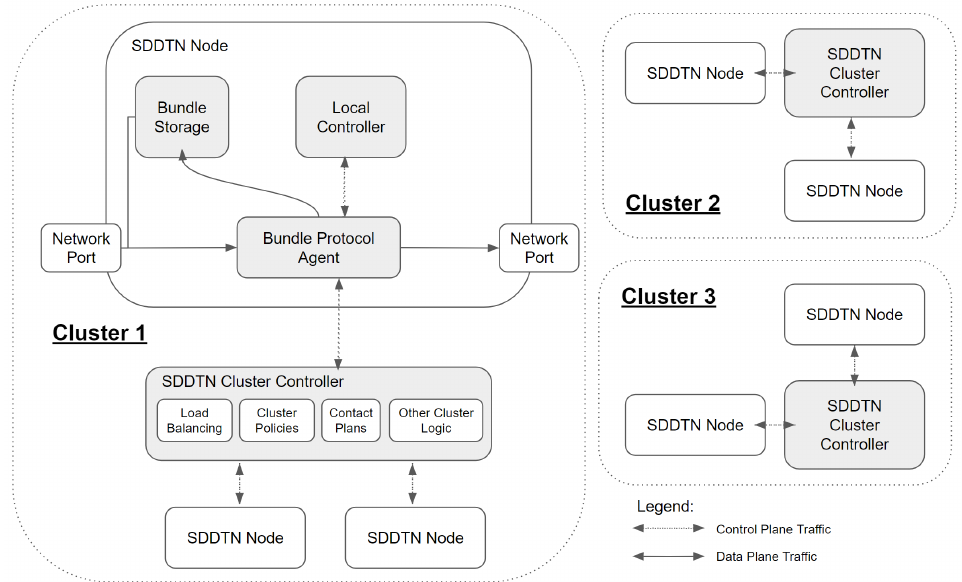
Figure 6. A Software-Defined Delay Tolerant Network architecture, with three clusters, each contain- ing an SDDTN controller managing SDDTN nodes via control plane links. A SDDTN node has all the behaviors of a typical DTN node, dictated by the abstract Bundle Protocol Agent, and also has communication with a local